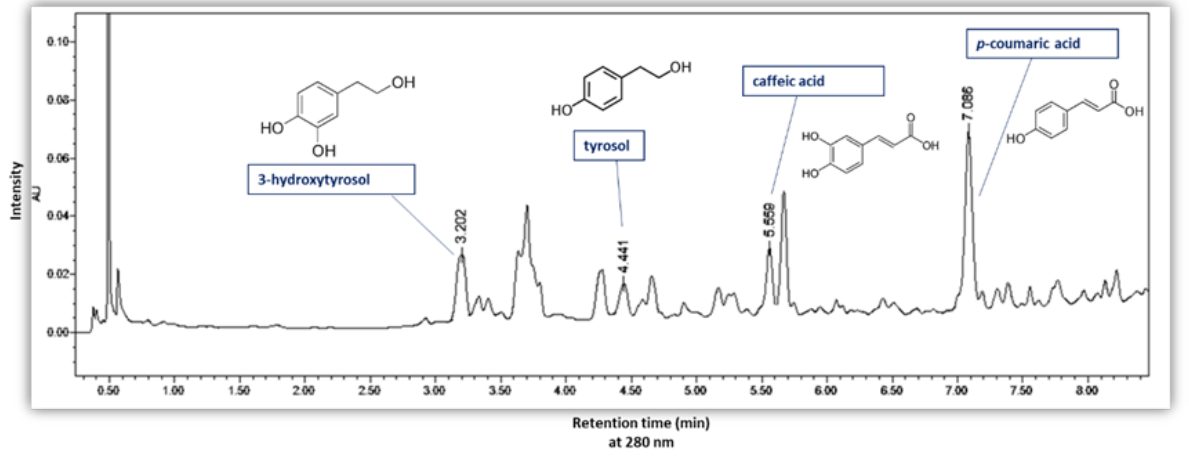
Figure 9. UPLC chromatogram of phenolic compounds from olive pomace powder extracted by ASE with detection at 280 nm.